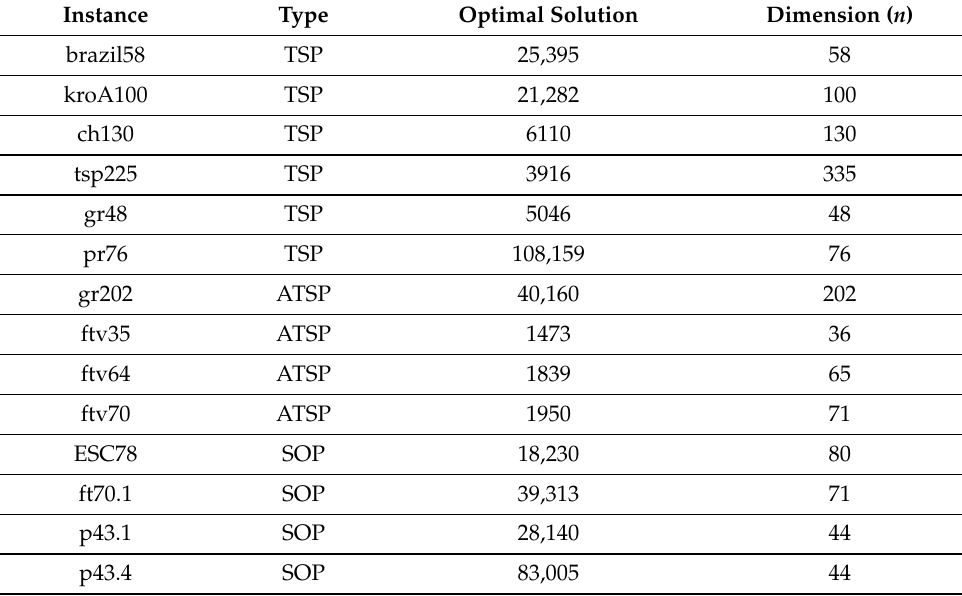
Table 1. Problem instances used in this paper for the experiments and